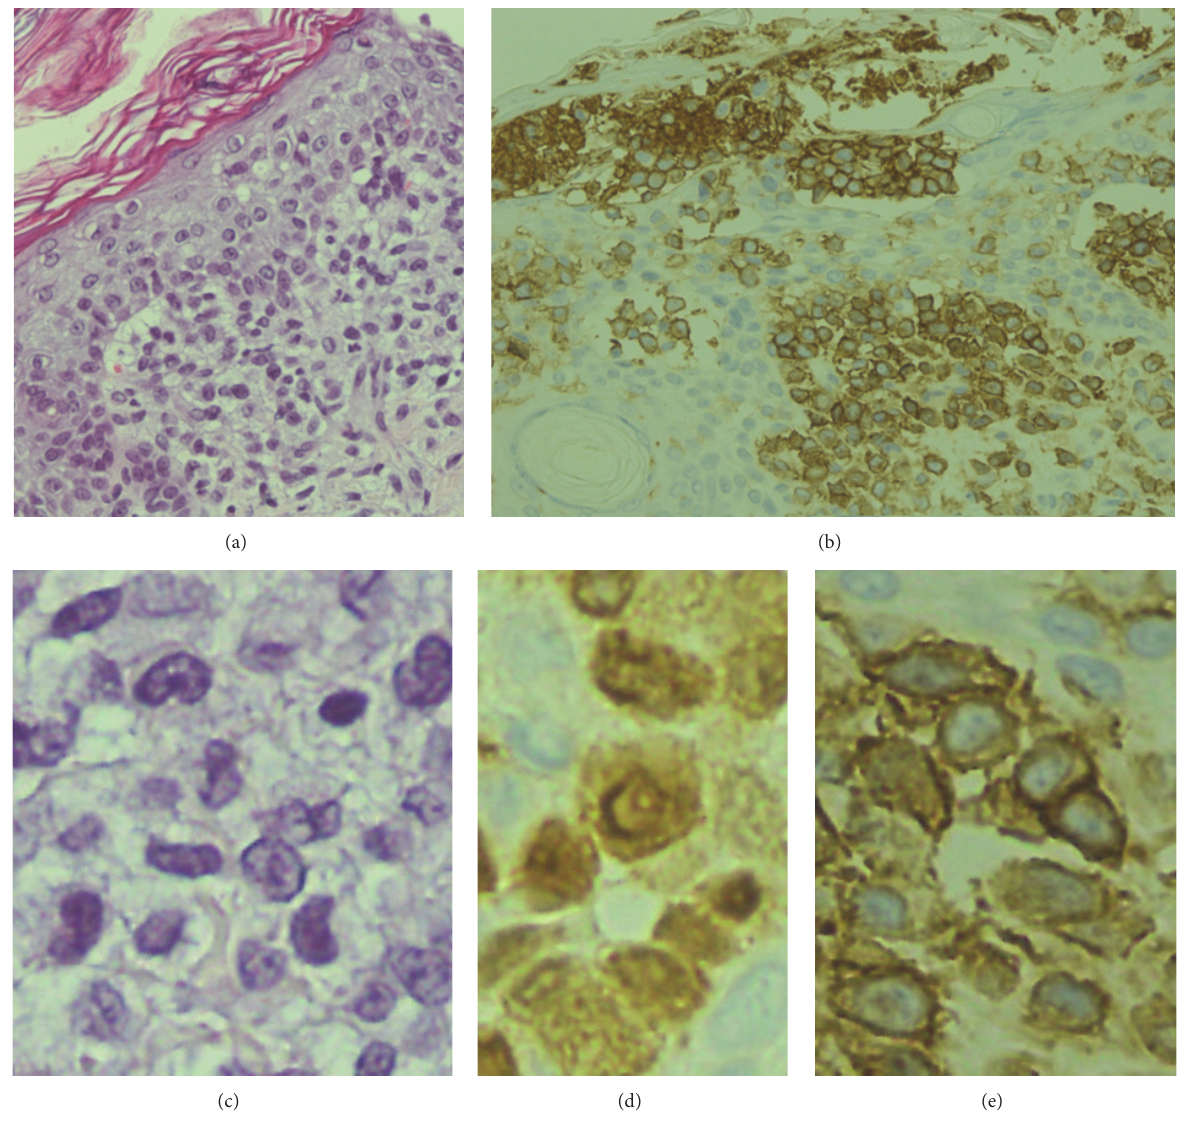
Figure 2: Histopathology of a cutaneous lesion showing histiocytic cell infiltration in the epidermis and dermis as well as under the stratum corneum ((a); HE stain), which were stained positive for CD1a (b) (original magnification, × 400), magnified photos showing characteristic folded “coffee bean” nucleus ((c); HE stain), positive S100 staining (d), and positive CD1a (e). Staining for E-cadherin and CD56 was negative (data not shown).